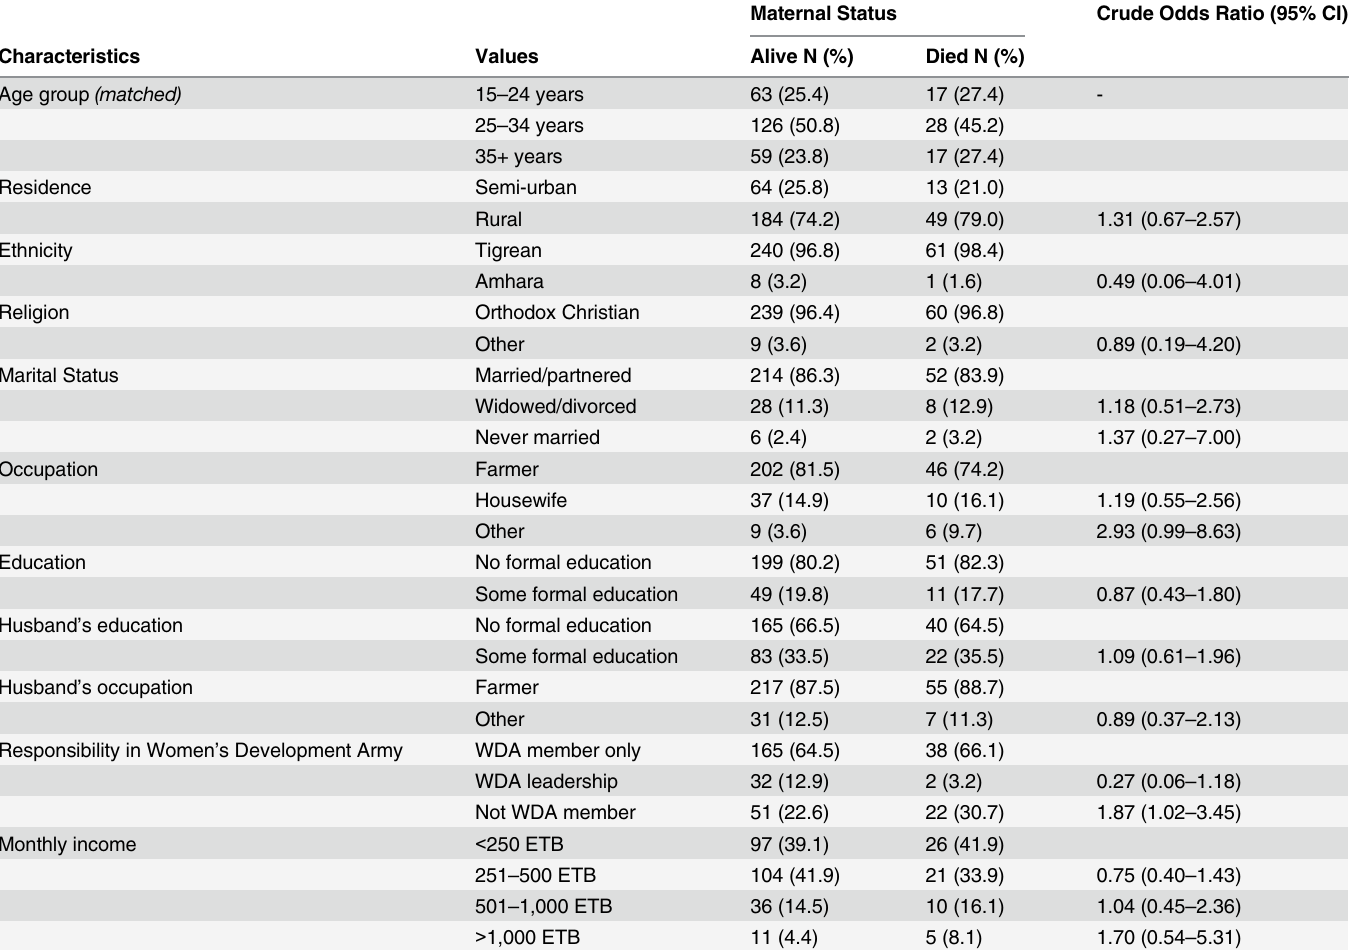
Table 1. Socio-demographic and cultural characteristics of 62 rural Tigrean women who died of maternal causes and 248 controls (who had given birth in the study period May 2012 to August 2013 and lived in the same communities as the maternal